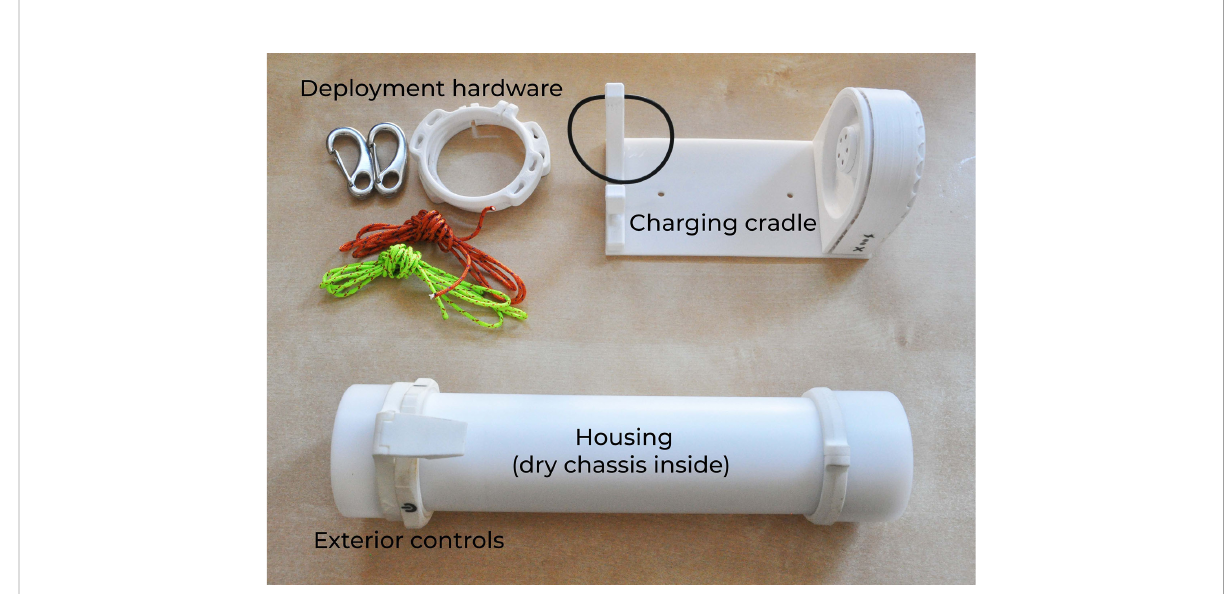
FIGURE 1 The mechanical components of the Maka Niu system include the pressure-rated housing, the dry chassis, the exterior controls, the deployment hardware, and the wireless charging